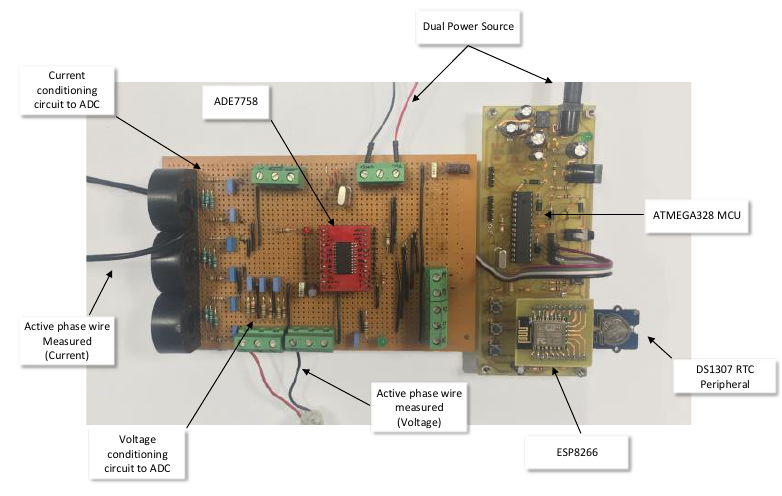
Figure 5. Prototype IoT PQ sensor board developed.